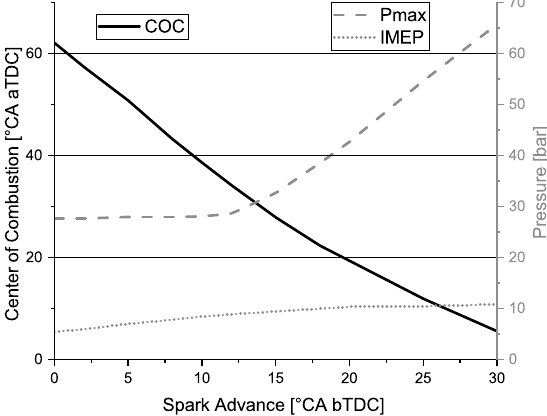
Figure 3. Center of combustion and maximum cylinder pressure as a function of the spark advance.